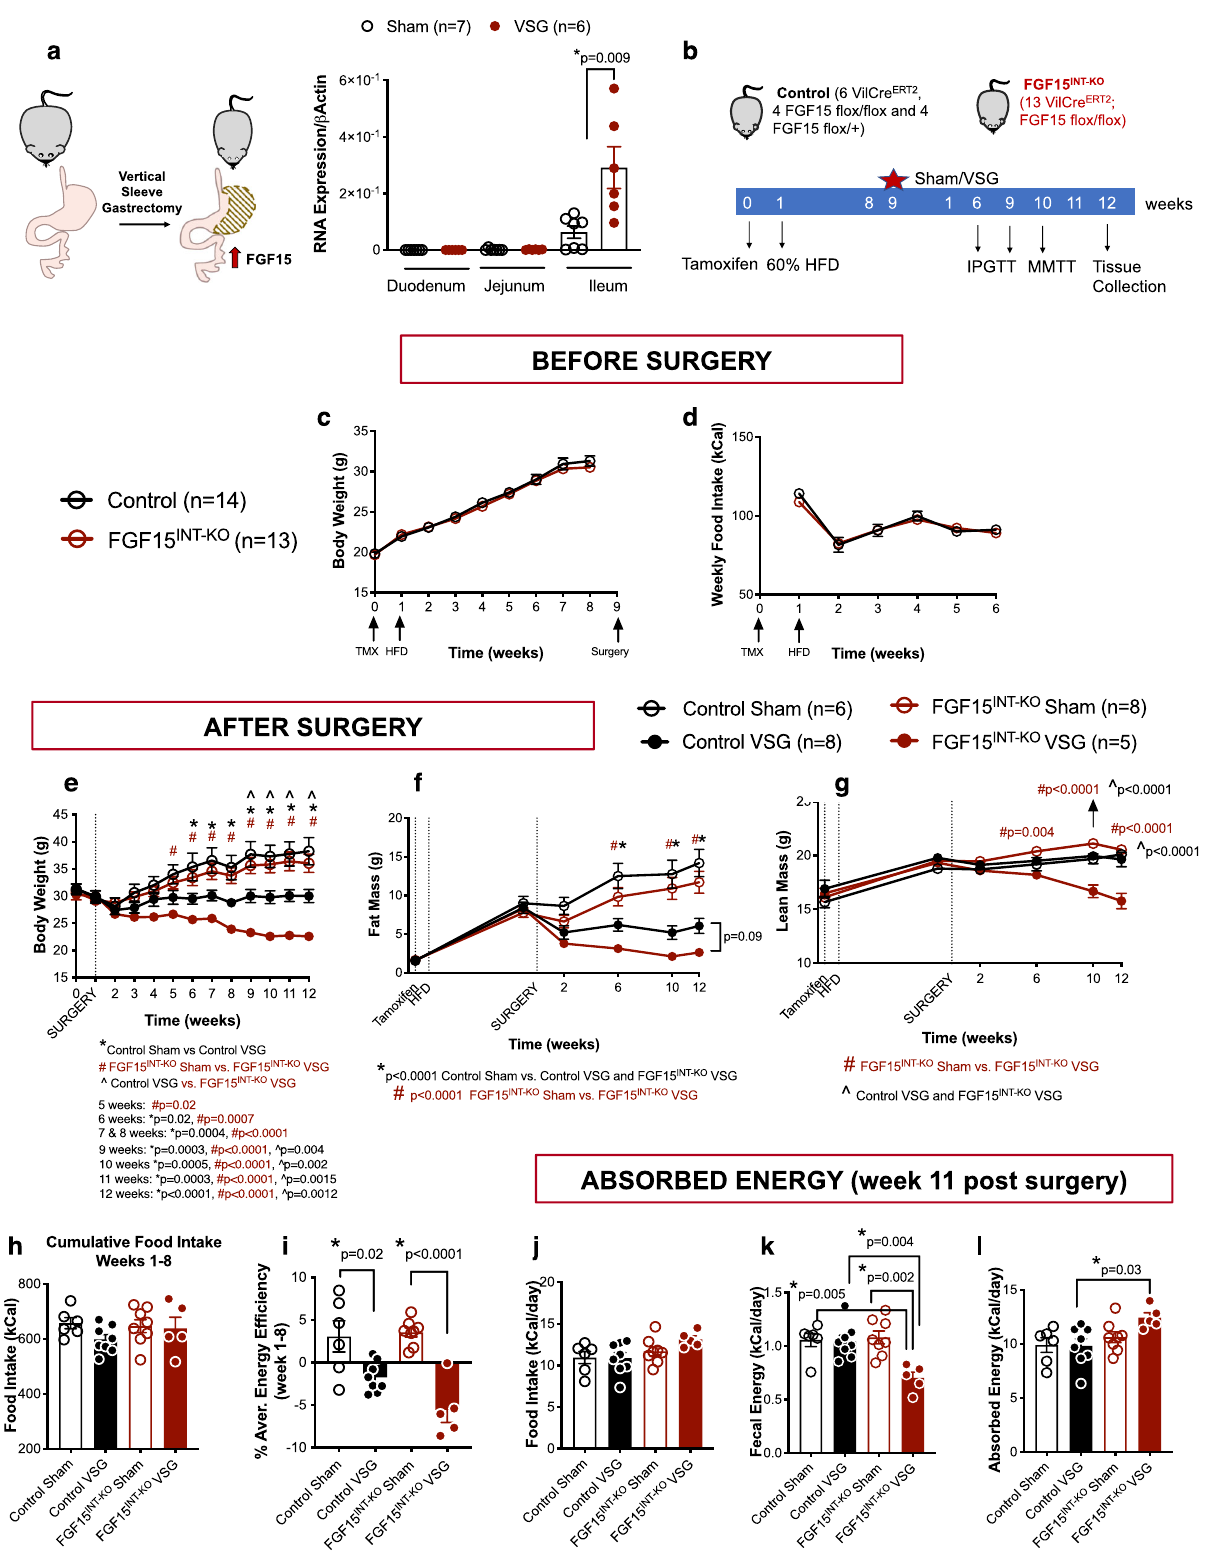
Fig. 1 Intestinal FGF15 expression increases and prevents muscle mass loss after VSG in mice. a FGF15 RNA expression in duodenum, jejunum and ileum in control Sham and VSG mice fed 60% HFD. Intestinal mucosa was collected 15min post mixed meal gavage ( n = 6 Sham and 7 VSG). b Experimental timeline. c Body weight and d food intake before surgery. e Body weight after surgery. f Fat body mass and g lean body mass before and after surgery. h Cumulative food intake and i energy ef fi ciency for weeks 1 – 8 after surgery. j Food intake, k fecal energy and l absorbed energy during week 11 after surgery. Animal number: Control Sham ( n = 6), Control VSG ( n = 8), FGF15 INT-KO Sham ( n = 8), FGF15 INT-KO VSG ( n = 5). Data are shown as means±SEM. Panels a , c , and d were analyzed with Student ’ s two-tailed t test. Panels e – l were analyzed with two-way ANOVA with Tukey ’ s post hoc test. * p <0.05.